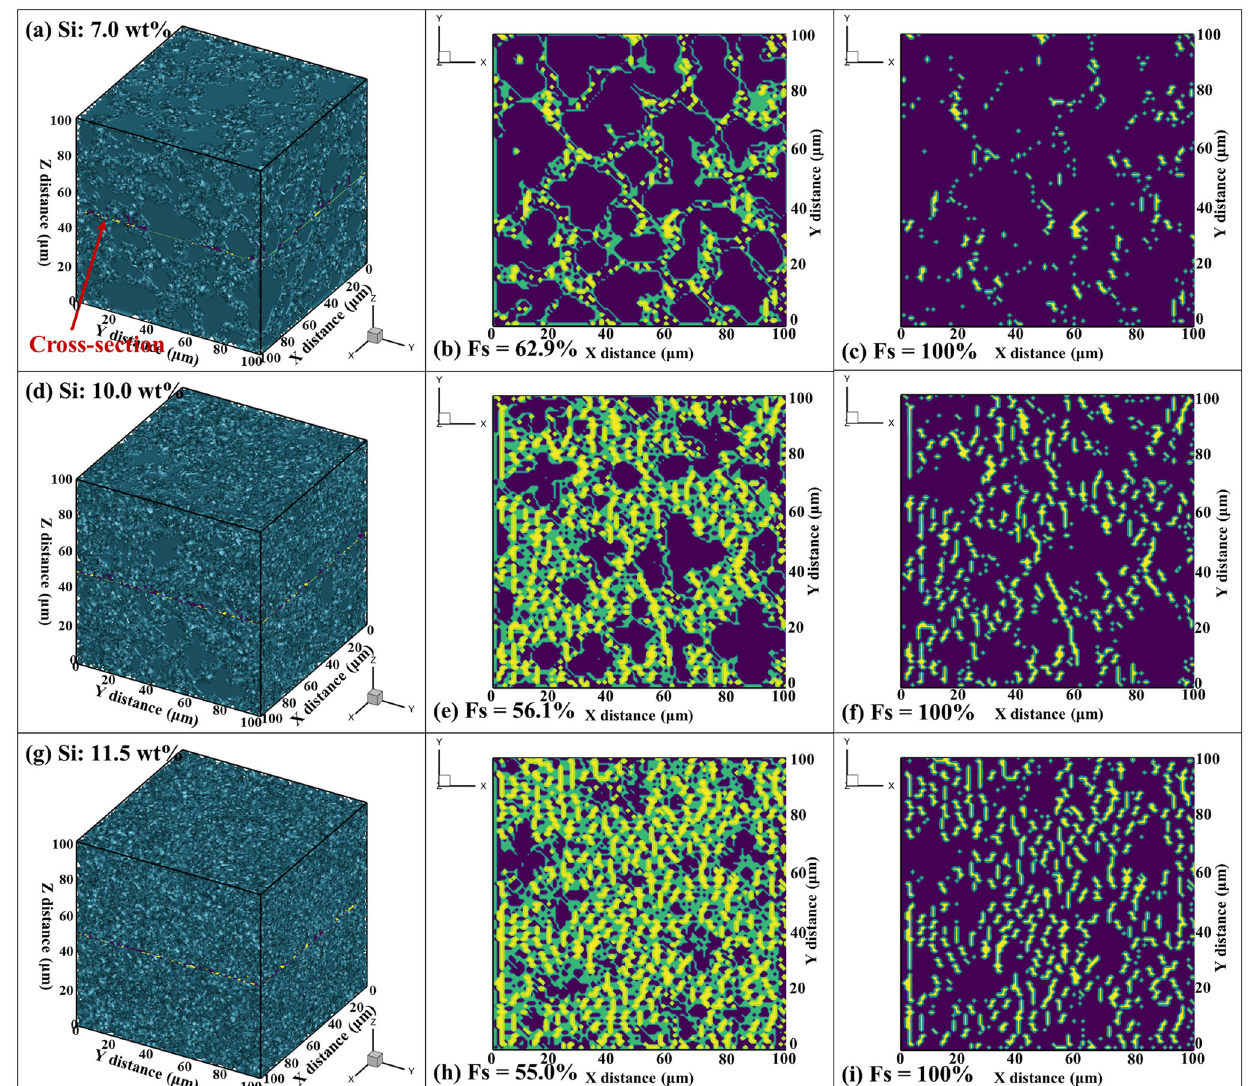
Fig. 7 Effect of Si concentration. 3-D simulation results of different initial Si concentrations: a Si: 7.0 wt%, b , c cross-section in ( a ), d Si: 10.0wt%, e , f cross-section in ( c ), g Si: 11.5 wt%, and h , i cross-section in ( e ). (In the cross-sections: α -Al is in blue color, Si is in yellow color, and the remaining liquid is in green